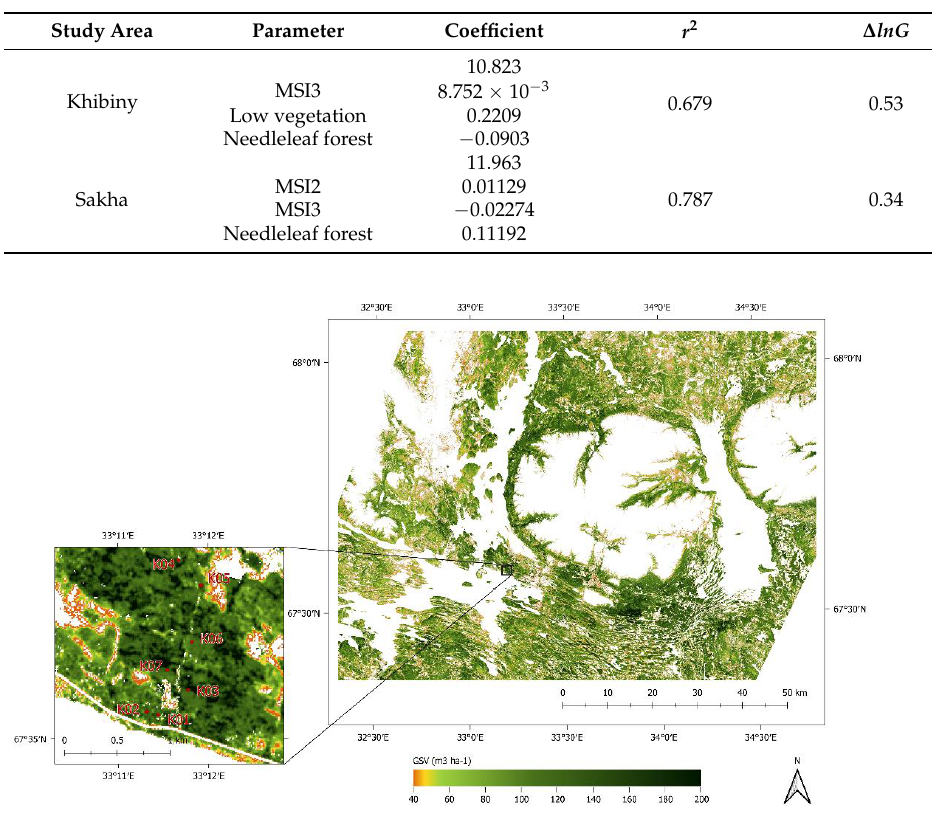
Figure 6. Modelled forest GSV in Khibiny. The inset shows one detailed region, which includes five field plots.